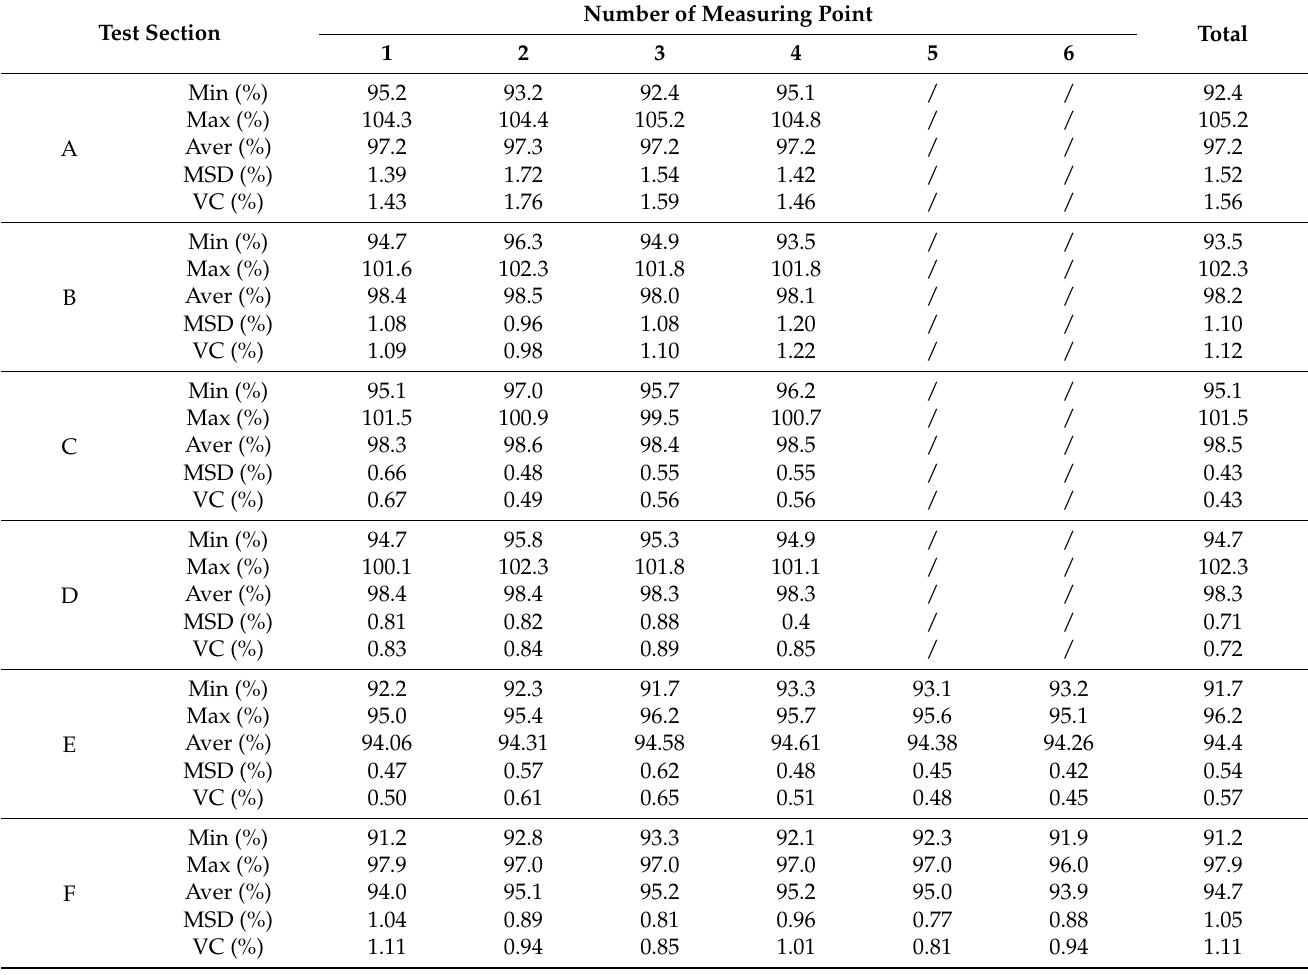
Table 4. Statistical analysis results of compaction